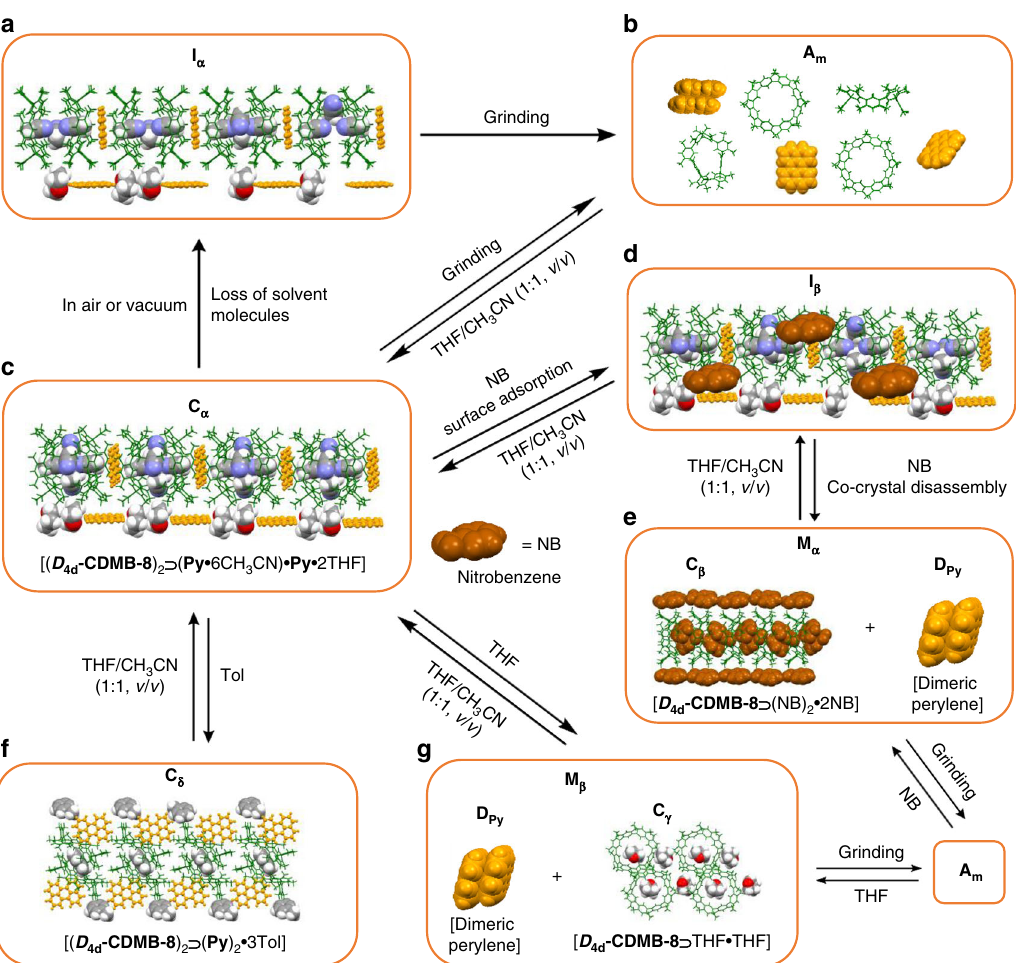
Fig. 2 Complexation and decomposition of host-guest complexes involving solid-state molecular motion. Structures of, and transformations between, the co-crystalline material C α , mixed crystalline species (e.g., M α and M β ), co-crystalline materials (i.e., I α , I β , and C δ ), and the amorphous form ( A m ) produced by exposure to organic solvents (vapour or liquid forms) or other treatments (e.g., grinding). a , b , d , e , g Suggested structures of I α , A m , I β , M α , and M β base on PXRD analysis, 1 H NMR, and fl uorescence spectroscopic studies. c , f Single crystal structure of co-crystals C α and C δ